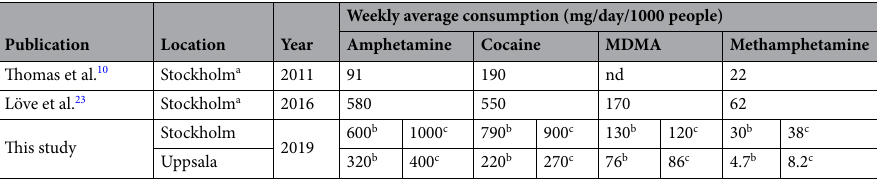
Table 3. Comparison of drug consumption using data from WBE studies conducted in Stockholm. nd: not detected. a Consumption estimated with correction factors of 2.77 (amphetamine), 3.59 (benzoylecgonine), 4.4 (MDMA), 2.44 (methamphetamine) in González-Mariño et al. 9 . b Campaign 1 in spring. c Campaign 2 in